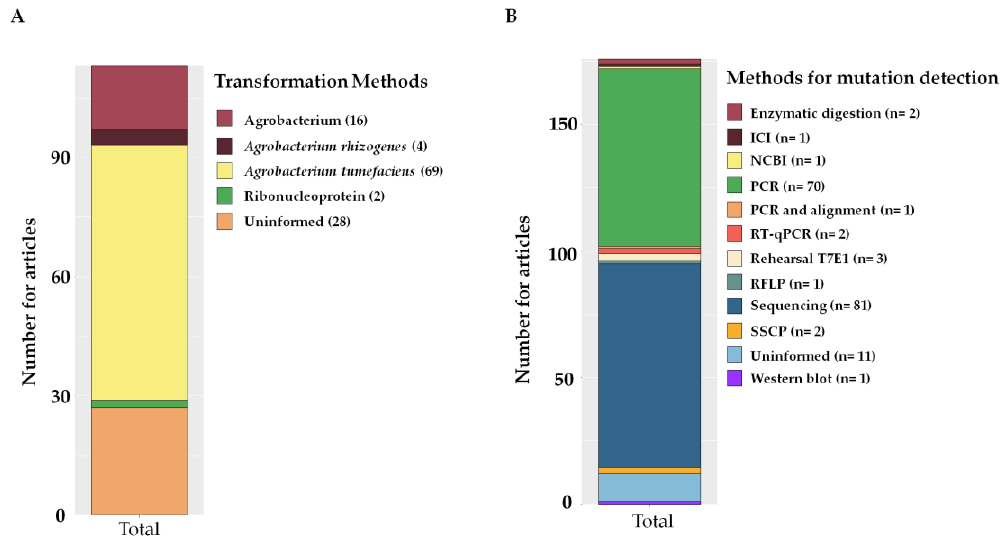
Figure 9. Graph of stacked bars represent the frequency of articles with different delivery methods and mutation detection with CRISPR/Cas. ( A ) Main delivery methods for genes of interest related to abiotic factors used in editing by CRISPR/Cas in the last seven years. ( B ) Methods used to detect mutations generated by CRISPR/Cas identified in articles from the last seven years. Determining the frequency involved considering that more than one method for mutation detection was used per article, n = number of articles.